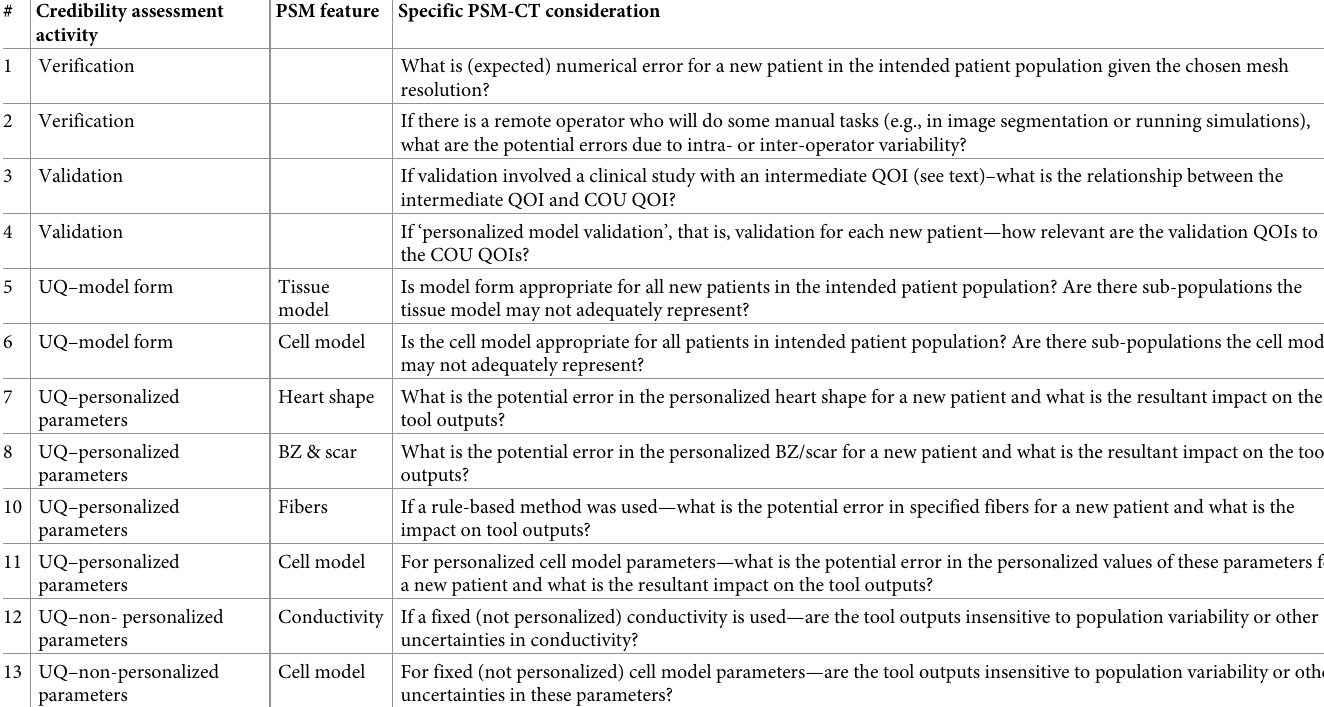
Table 1. Example specific credibility-related considerations for patient-specific models as clinical tools. Acronyms: UQ–uncertainty quantification; QOI–quantity of interest; COU–context of use; BZ–border zone. # Credibility assessment PSM feature Specific PSM-CT activity